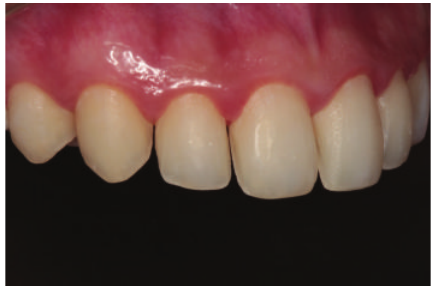
Figure 8: Teeth after removal of temporaries. Note the improvement in papillae after removal of the resins that were causing